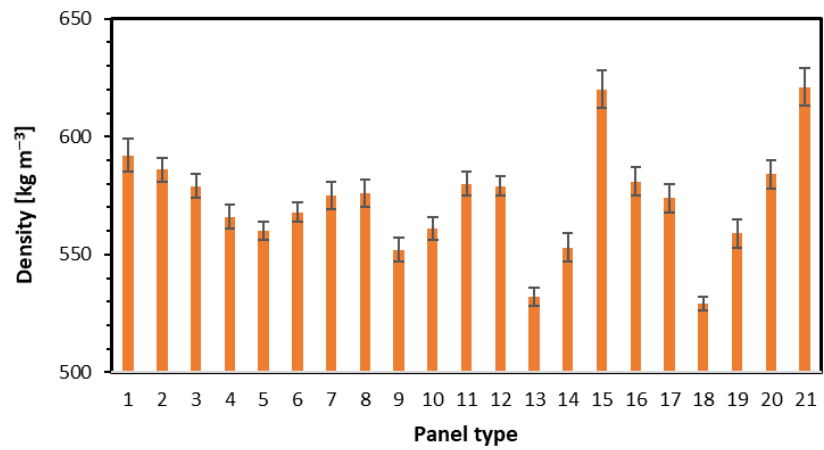
Figure 6. The density of the core layers (middle of thickness) of tested panels.